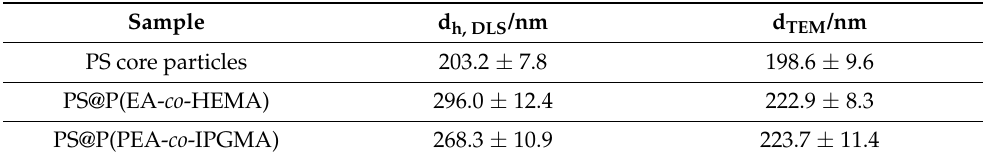
Table 1. Summary of the average particle diameter after each synthesis step determined by DLS and